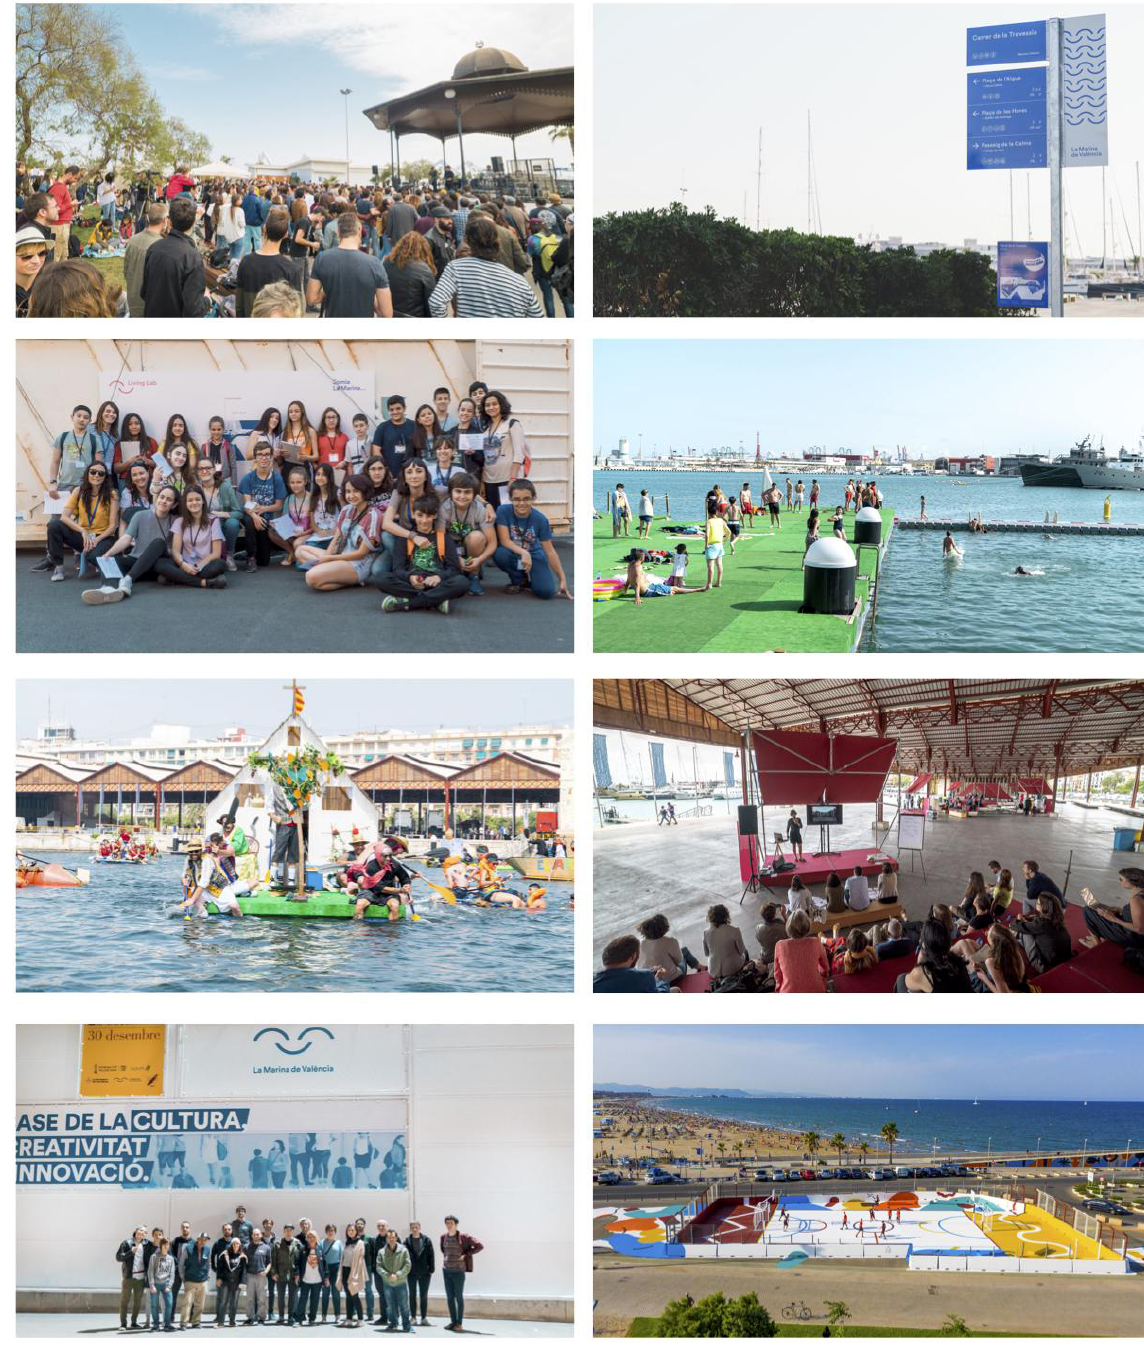
Figure 4. Experiments at LMdV. From left to right and top to bottom: Concert at La Pérgola; signals at Veus de La Marina; participants at SUREM project; ocean pool; crazy boats race; Placemaking Week; participants at a co-design workshop for the skatepark; and basketball court. Source: Courtesy of